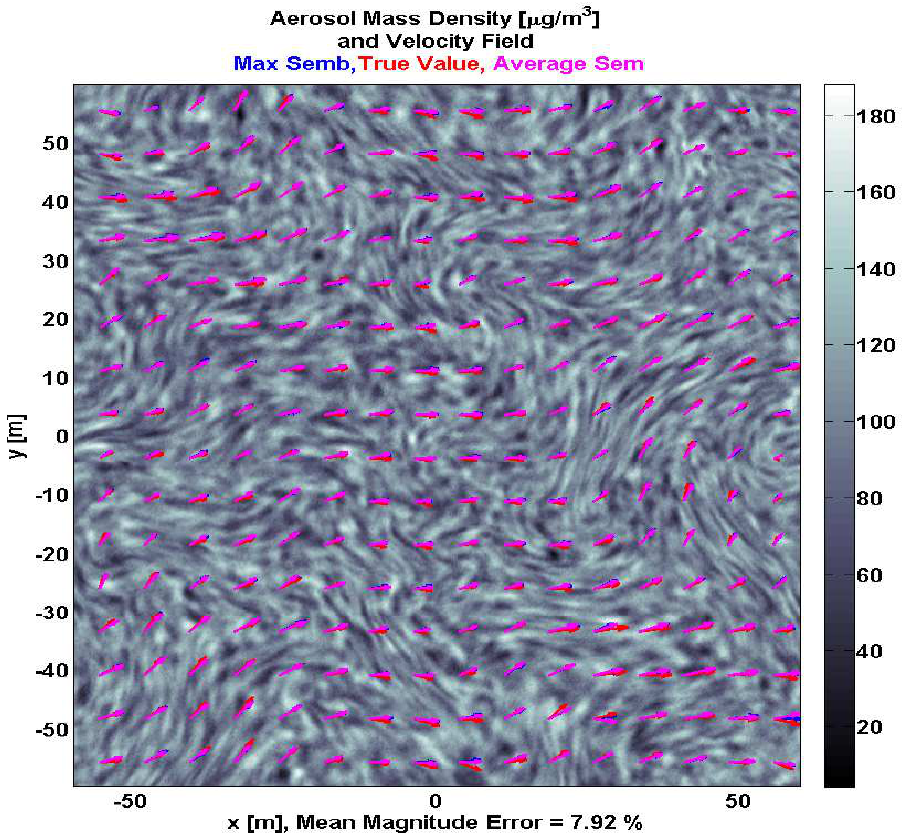
Figure 3. Segmented SM processing result for one frame of stochastic cloud model data. Color bar scale aerosol density units are µg/m 3